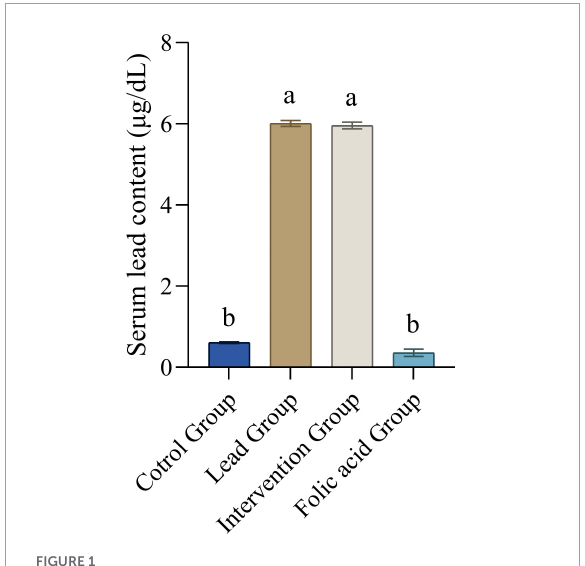
FIGURE1 Effect of folic acid on serum lead content of lead-exposed rats ( n = 10). Data were presented as mean ± SD. Different superscript letters indicate differences ( P <